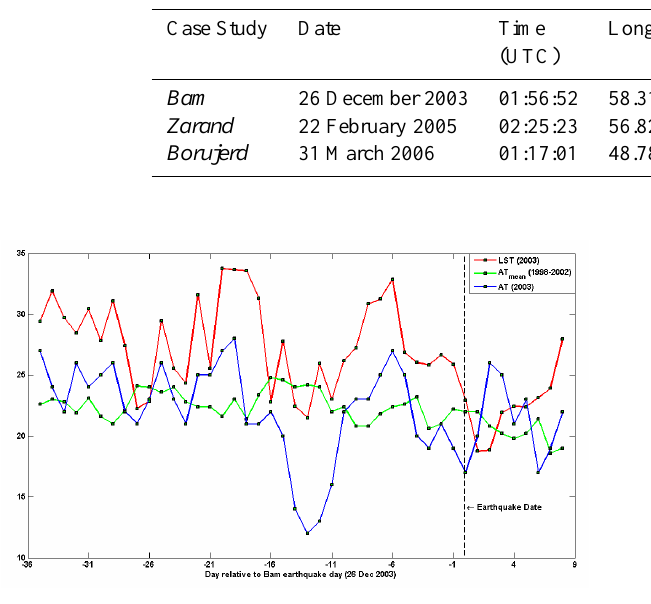
Fig. 1. Results of LST and AT data analysis for the Bam earthquake (26 December 2003) from 20 November 2003 to 3 January 2004. The red and blue curves represent the LST and AT variations. The mean of AT during the period of 20 November to 3 January from 1998 to 2002 is represented as a green curve. The x -axis repre- sents the day relative to the earthquake day. The earthquake day is represented as a vertical dotted line.